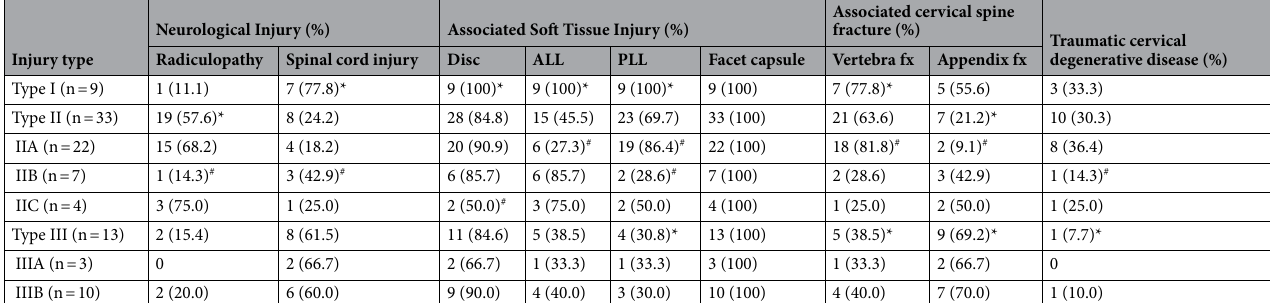
Table 4. Initial neurological status, intervertebral disc and ligamentous injury on the magnetic resonance images according to each type (or) subtype of classification in patients with UCLF. ALL, anterior longitudinal ligament; PLL, posterior longitudinal ligament. *Indicates a significant difference among the three types of UCLF based on the Chi-square test, p < 0.05. # Indicates a significant difference among the three subtypes of type II based on the Fisher exact test, p <